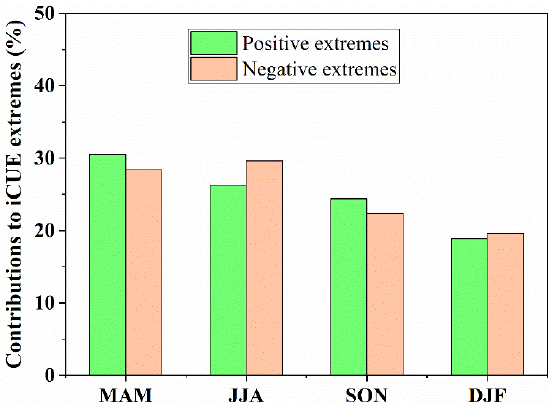
susceptible to carbon transformation proficiency.